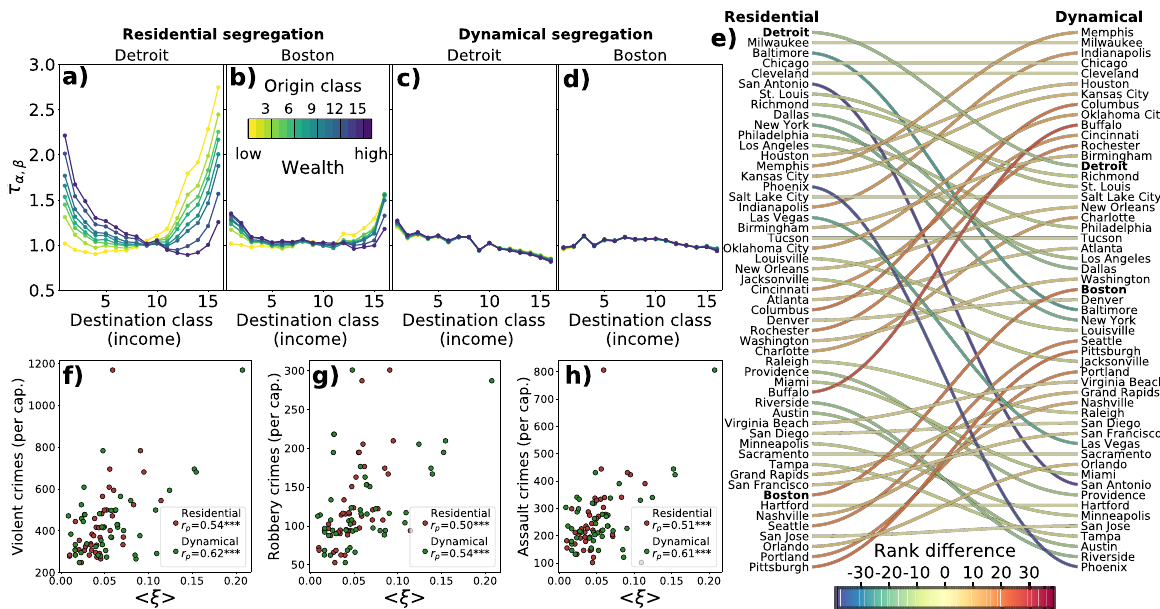
Fig. 7 Class mean fi rst passage times and urban income inequality. a – d Normalised class mean fi rst passage times from class α to class β e τ αβ between each of the income categories in Detroit and Boston when computed over the adjacency graphs (residential segregation, a and b ) and the commuting graphs, respectively (dynamical segregation, c and d ). Each class corresponds to an income bracket provided by the US census: Class 1 is the poorest, while Class 16 is the wealthiest. See Supplementary Table 2 for details on the average income of each class. e Changes in the ranking of the residential and dynamical 〈 ξ 〉 starting with higher values on top and lower values at the bottom. f – h Correlation between the index of segregation 〈 ξ 〉 in US cities and the levels of f ) violent crimes, g ) robbery crimes and h ) assault crimes per capita. r p stands for the Pearson correlation coef fi cient and the signi fi cance is determined by the p value (* p < 0.05, ** p < 0.01, *** p <